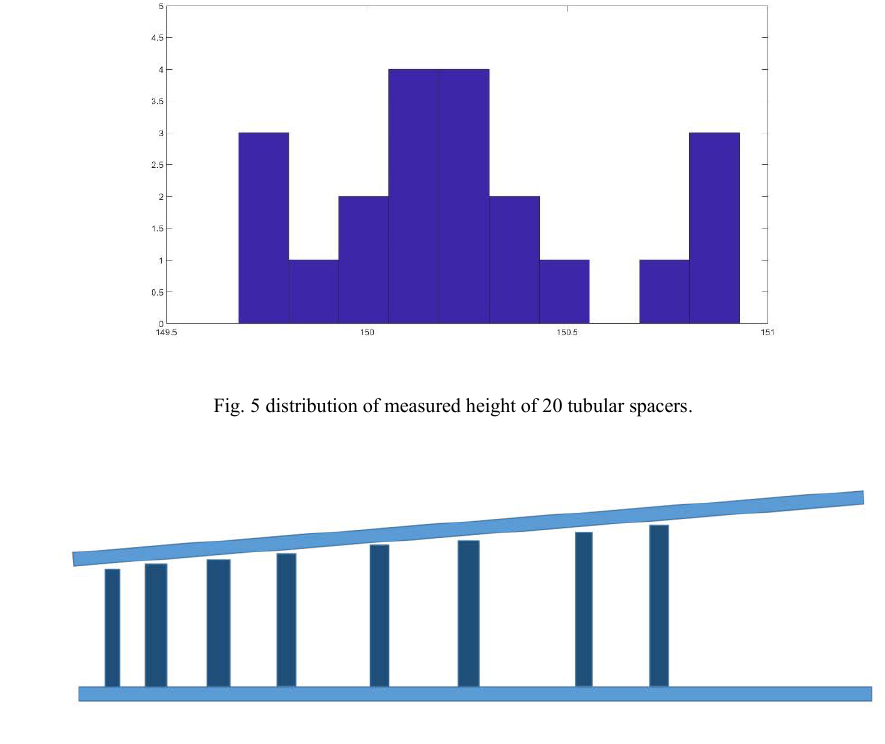
Fig. 6 Placement of spacers in the panel, short ones on the left, taller ones on the right, scale is